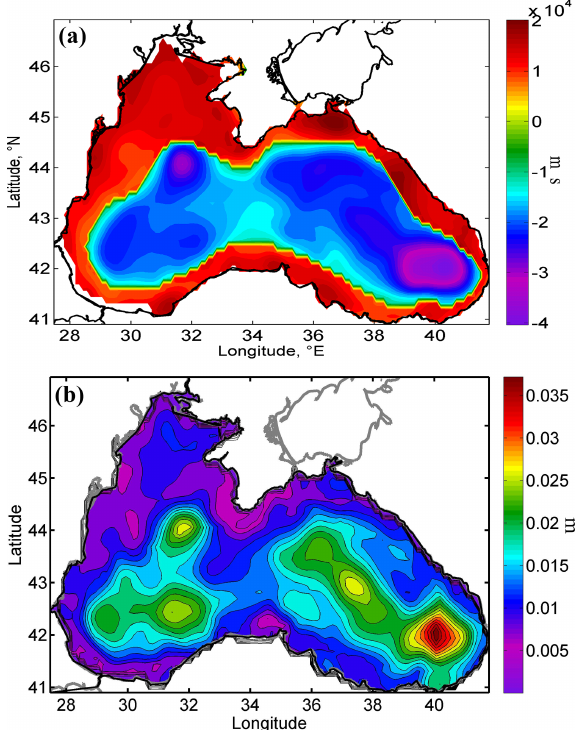
Figure 9. (a) Linear regression coefficients ( k ) between the basin- averaged wind curl and DSL (DSL = k × W + ε) . (b) Standard devia- tions of the error term (the difference between the altimetry-derived and reconstructed DSL); time series are smoothed with a 1-year moving average.